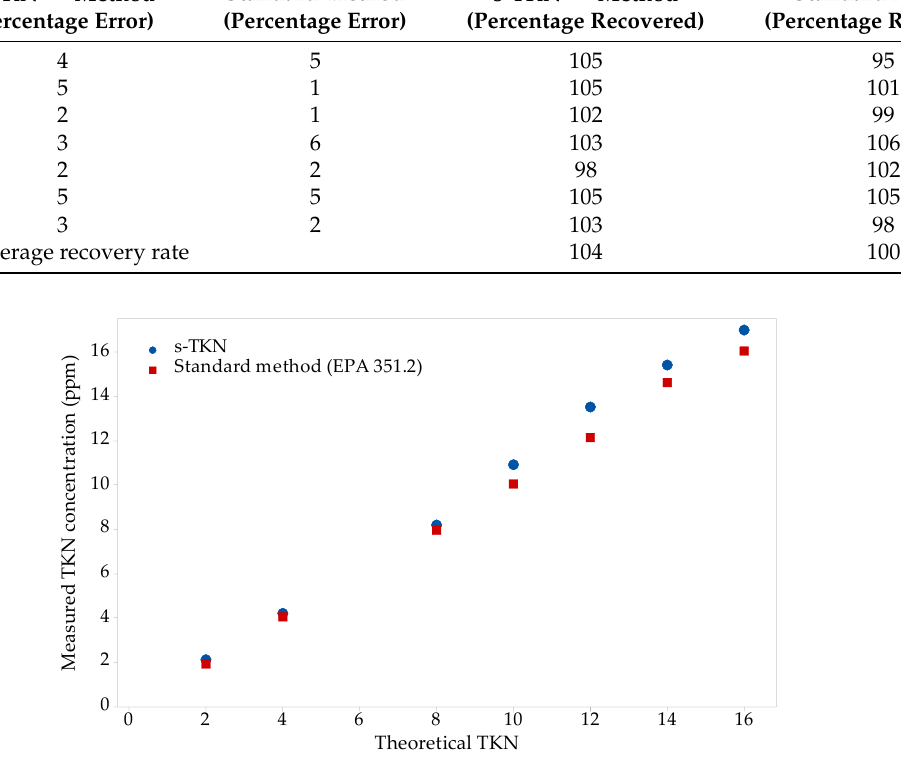
Figure 4. Contour plot for the error percentage in measured TKN concentrations obtained using the s-TKN TM method. Figure 5. Contour plot for the relative standard deviation in measured TKN concentrations obtained using the s-TKN TM method.